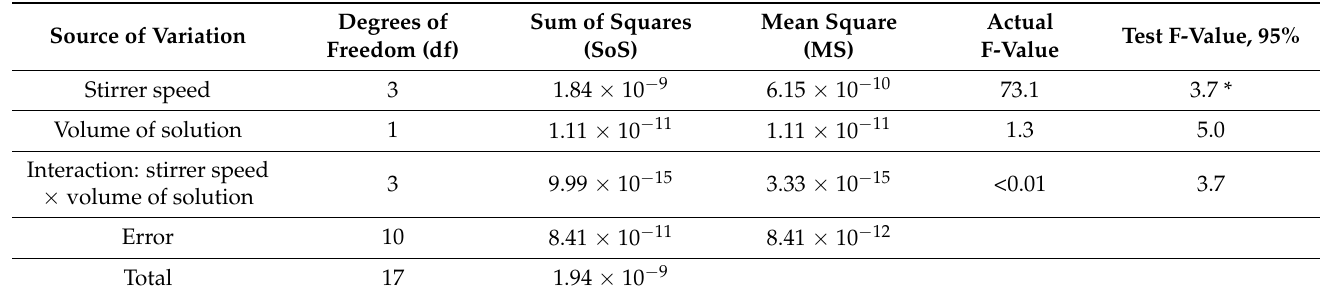
Table 4. ANOVA for the mass-transfer coefficients from the 13 mm tablets, USP dissolution apparatus 2 (paddle) (* means significant at 95% confidence